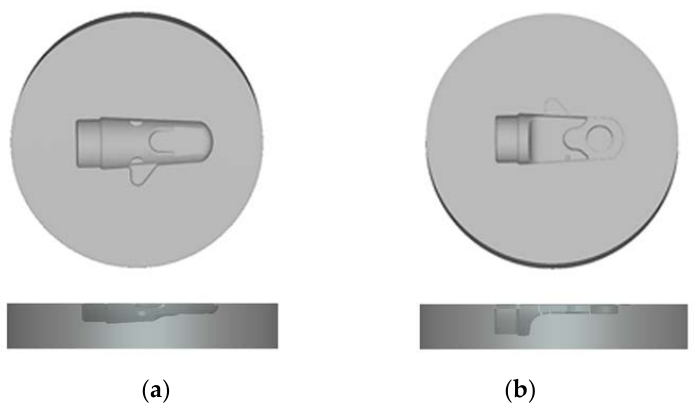
Figure 4. 3D solid models of non-axisymmetric punches in cold orbital forming the aluminum alloy component: ( a ) rocking punch; ( b ) lower die.